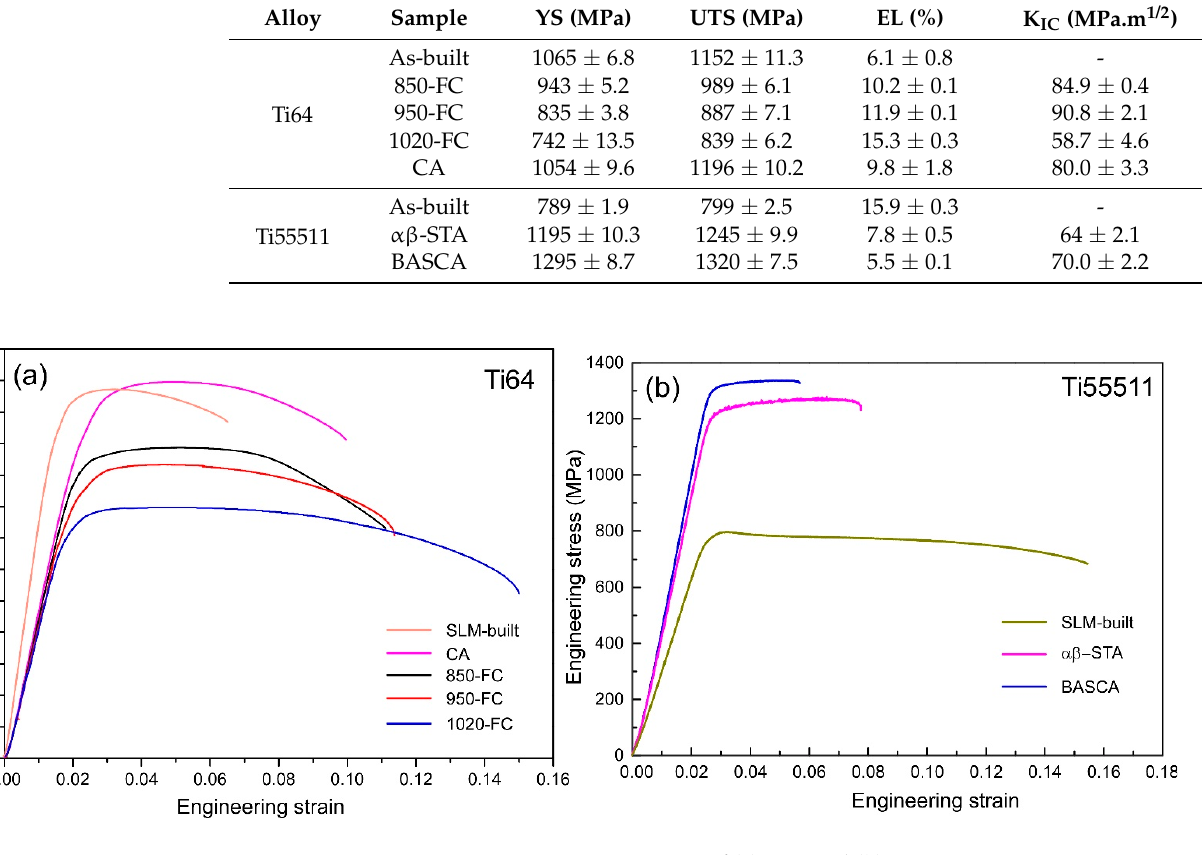
Figure 9. Representative engineering stress-strain curves of ( a ) Ti64 and ( b ) Ti55511. Figure 10 illuminates the morphological details with respect to the cross-sectional